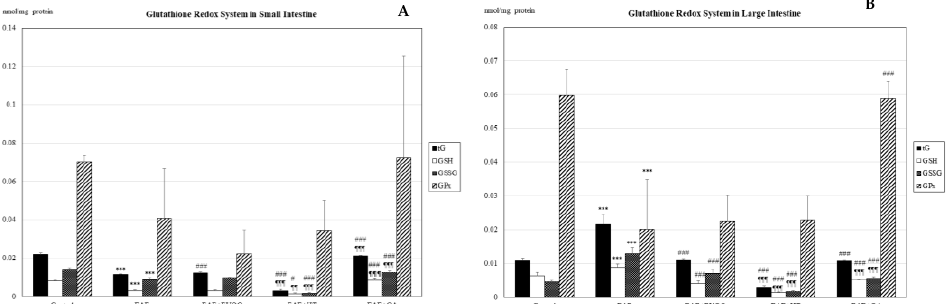
Figure 1. Glutathione redox system in the small intestine ( A ) and large intestine ( B ): total glutathione (tG; nmol / mg protein), reduced glutathione (GSH; nmol / mg protein), oxidized glutathione (GSSG; nmol / mg protein), and glutathione peroxidase (GPx; nmol / mg protein) in the following study groups: control group (not manipulated); EAE group (experimental autoimmune encephalomyelitis induced by myelin oligodendrocyte glycoprotein (MOG)); EAE + extra-virgin olive oil (EVOO); EAE + hydroxytirosol group (HT); and EAE + oleic acid group (OA). *** p < 0.001 vs. control; # < p < 0.05 vs. EAE; ### p < 0.001 vs. EAE; ¶¶ p < 0.01 vs. EAE + EVOO; ¶¶¶ p < 0.001 vs. EAE +